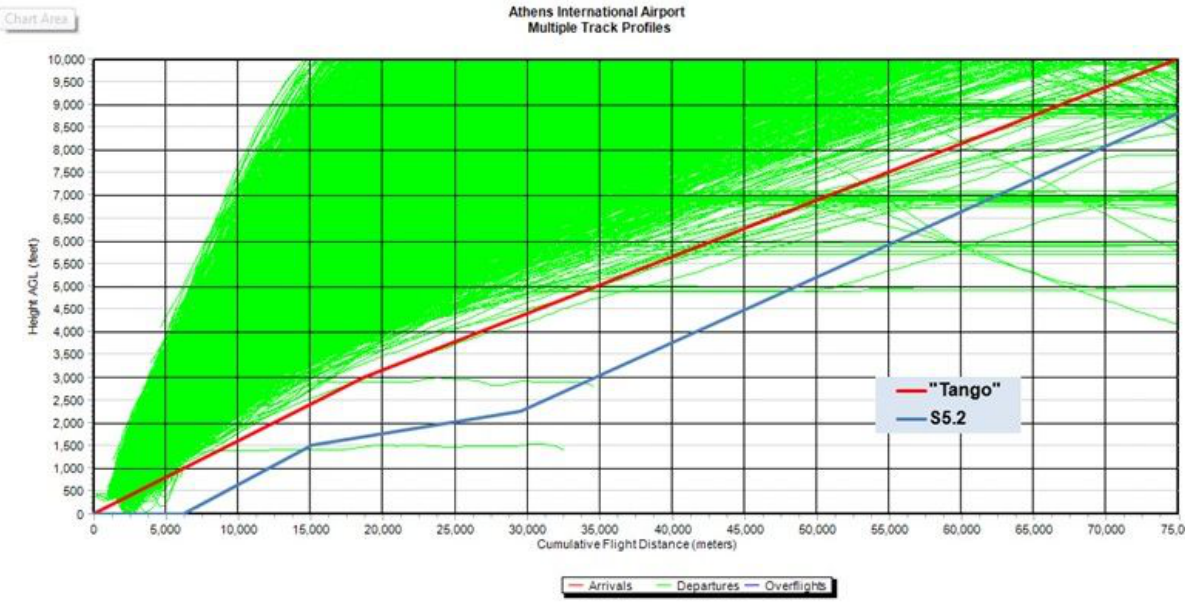
Figure 2: Actual flight paths VS